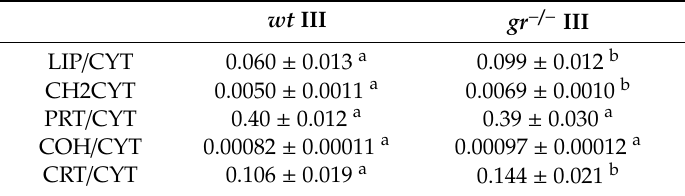
Table 2. Biochemical composition of the cytoplasm of class III wt and gr − / − oocytes. wt III